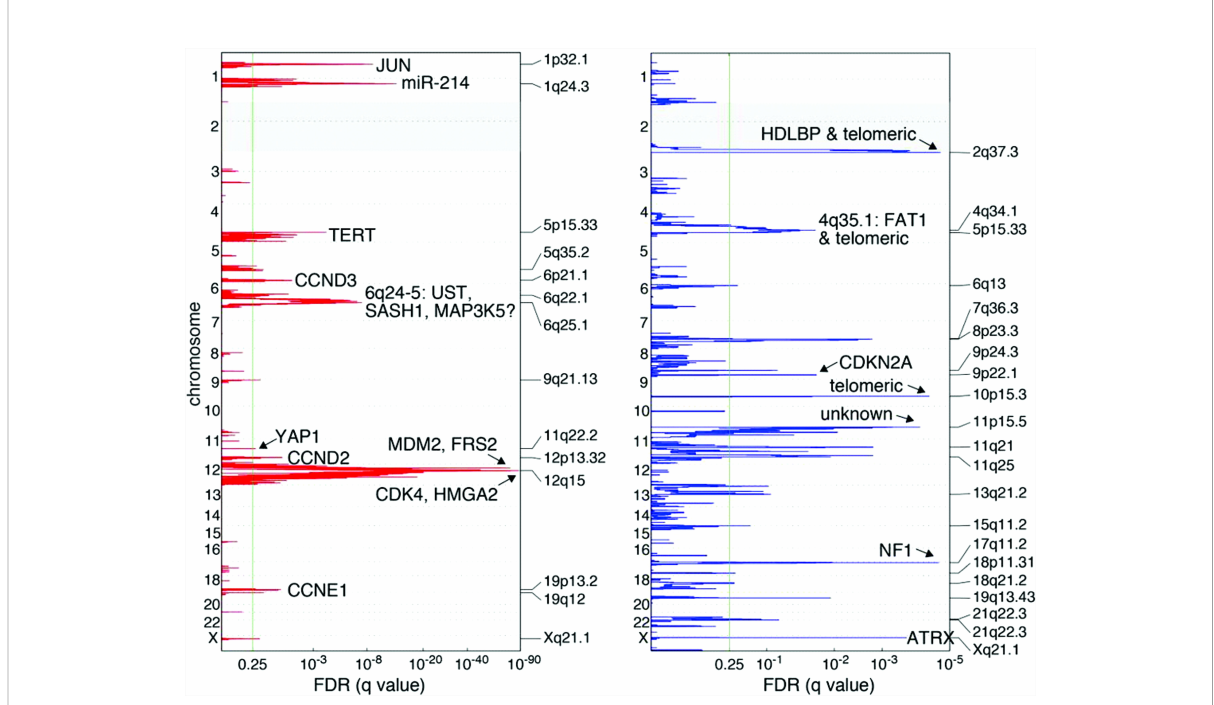
FIGURE 2 Recurrent genetic alterations among 50 DDLPS samples. Ampli fi cation in red, deletions in blue. Green line indicates the signi fi cance threshold for focally ampli fi ed or deleted genes. Adapted from Comprehensive and Integrated Genomic Characterization of Adult Soft Tissue Sarcomas